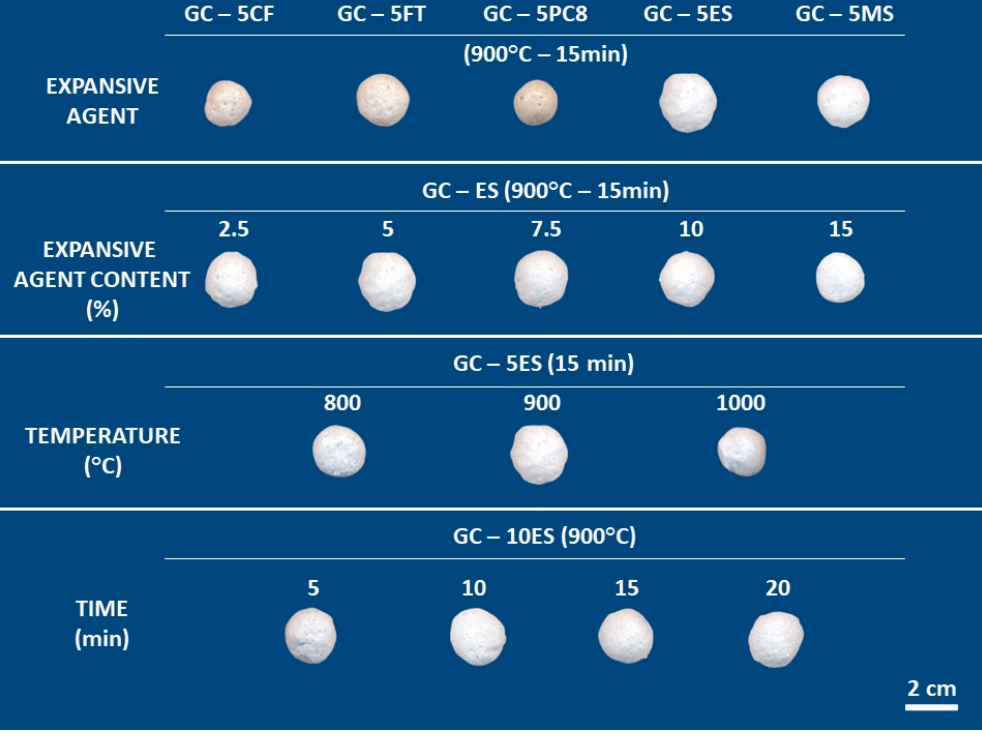
Figure 8. Evolution of linear expansion (LE) of hand–formed pellets with ( a ) temperature and ex- pansive agent percentage, and ( b ) temperature and dwell time.